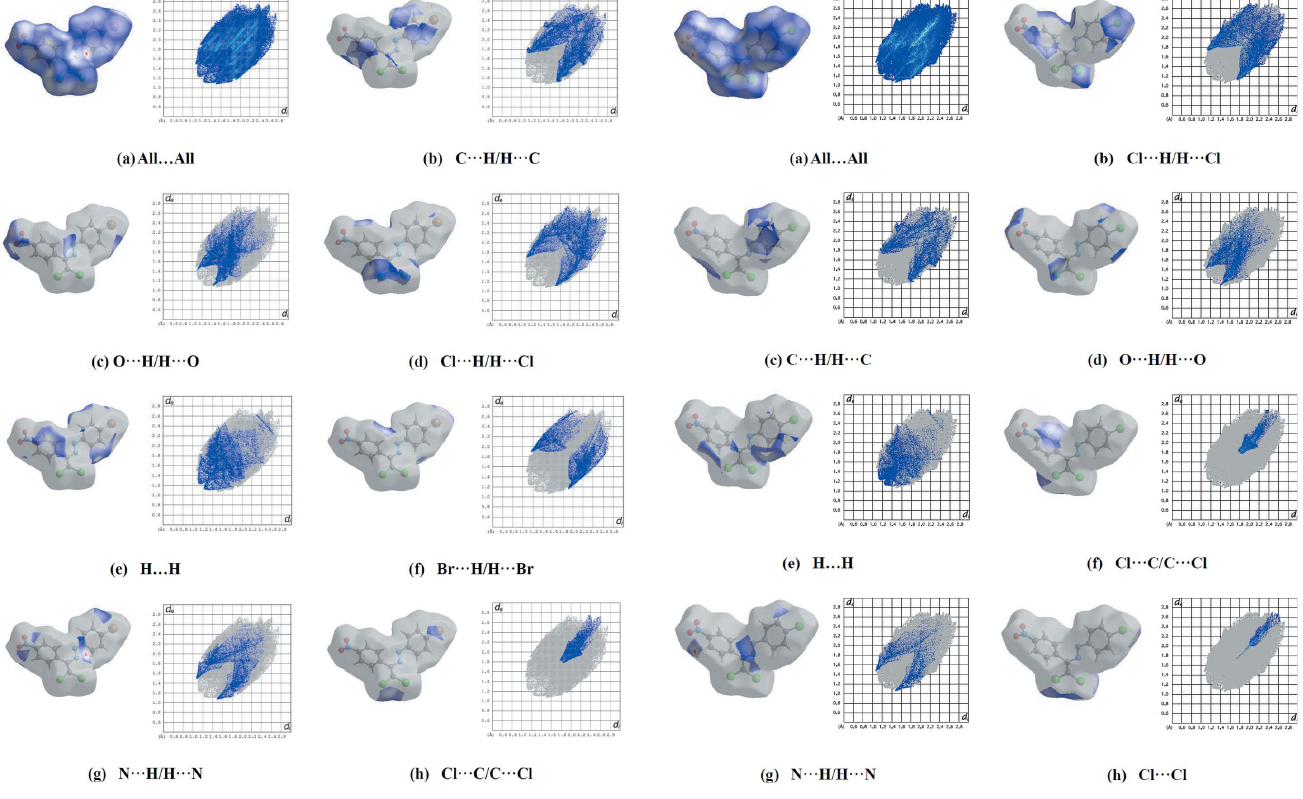
Figure 6 Hirshfeld surface representations and full two-dimensional fingerprint plots for (I), showing ( a ) all interactions, and delineated into ( b ) C (cid:3)(cid:3)(cid:3) H/ H (cid:3)(cid:3)(cid:3) C ( c ), O (cid:3)(cid:3)(cid:3) H/H (cid:3)(cid:3)(cid:3) O ( d ), Cl (cid:3)(cid:3)(cid:3) H/H (cid:3)(cid:3)(cid:3) Cl ( e ), H (cid:3)(cid:3)(cid:3) H ( f ), Br (cid:3)(cid:3)(cid:3) H/ H (cid:3)(cid:3)(cid:3) Br ( g ), N (cid:3)(cid:3)(cid:3) H/H (cid:3)(cid:3)(cid:3) N and ( h ) Cl (cid:3)(cid:3)(cid:3) C/C (cid:3)(cid:3)(cid:3) Cl interactions. The d i and d e values are the closest internal and external distances (in A˚ ) from a given point on the Hirshfeld surface.